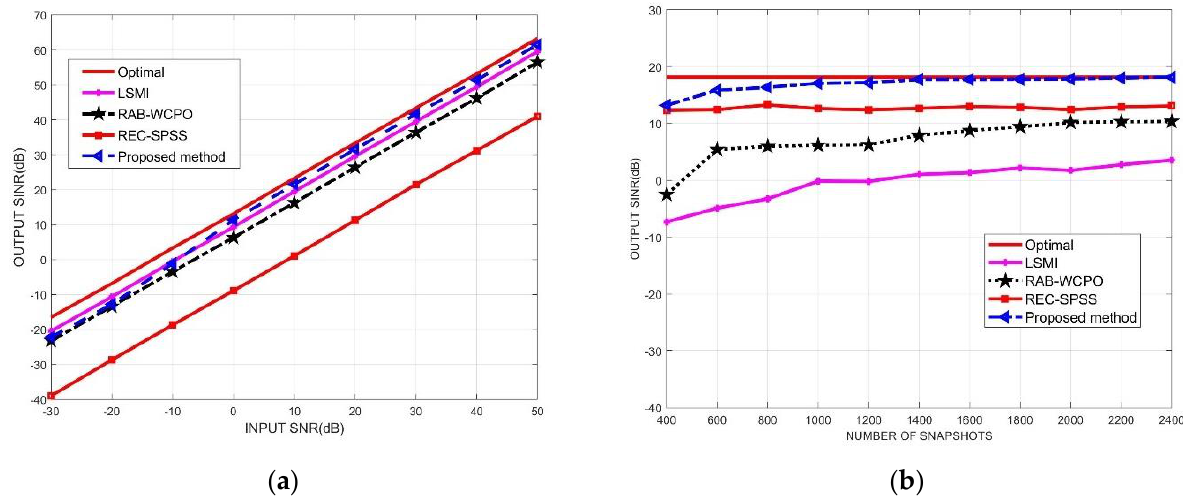
Figure 5. Output SINR of array antenna versus input SNR and number of snapshots, respectively. ( a ) output SINR versus input SNR; ( b ) output SINR versus number of snapshots.